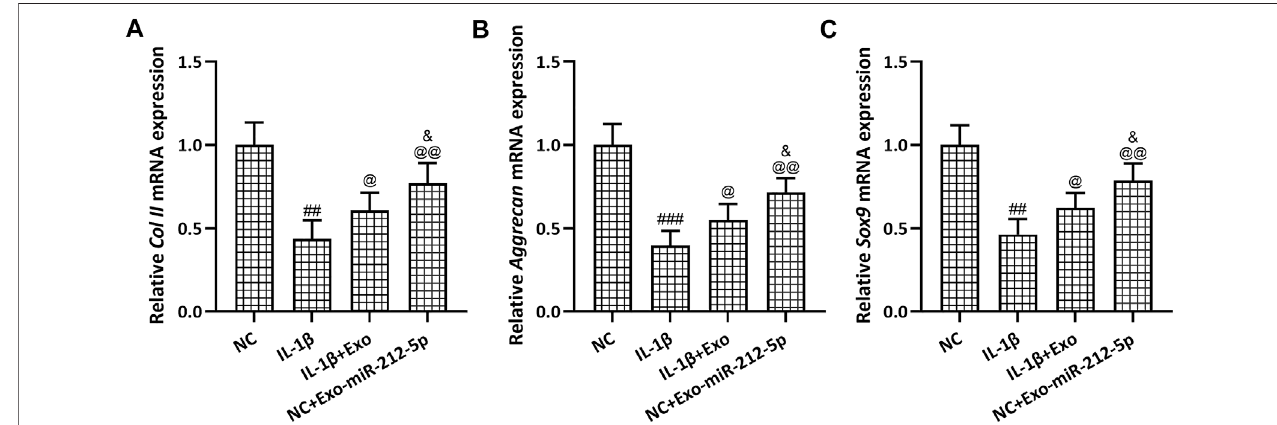
FIGURE5| SMSC-212-5p-ExosattenuatedIL-1 β inducedchondrocytedegeneration.IL-1 β inducedchondrocytesweretreatedwithSMSC-ExosorSMSC-212- 5p-Exosfor48 hqRT-PCRwasutilizedtoanalyzethemRNAexpressionsofCollagenII (A) ,Aggrecan (B) andSox9 (C) . n =3foreachgroup.## p < 0.01, ### p < 0.001 compared to NC. @ p < 0.05, @@ p < 0.01 compared to IL-1 β . & p < 0.05 compared to IL-1 β +Exo. One-way ANOVA followed Dunn ’ s multiple comparisons test.